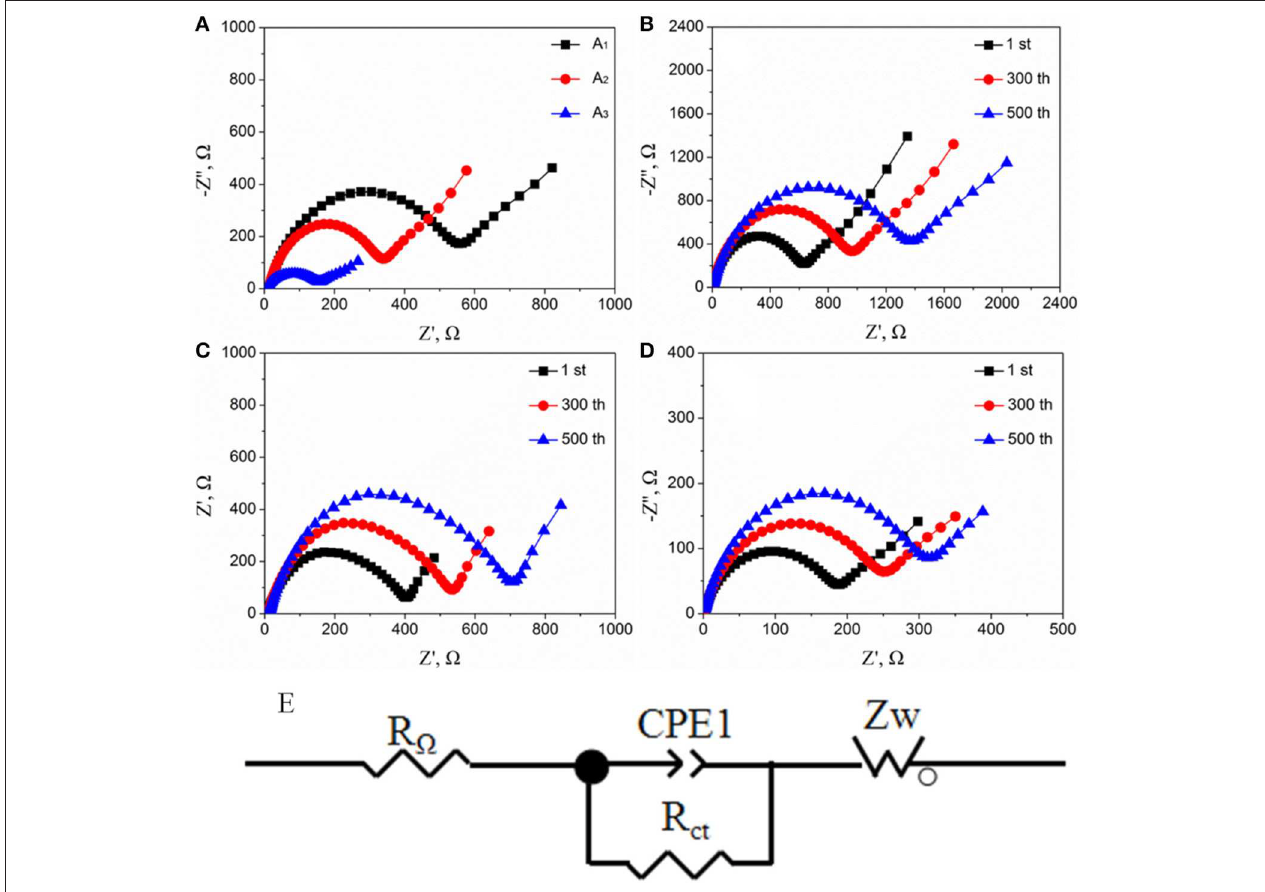
FIGURE 9 | (A) Nyquist plots of all samples [(A 1 ) pure LFP, (A 2 ) LFP/C, and (A 3 ) LFPF/CF] before cycling, (B) pure LFP, (C) LFP/C, and (D) LFPF/CF after cycling at 5C, (E) equivalent circuit